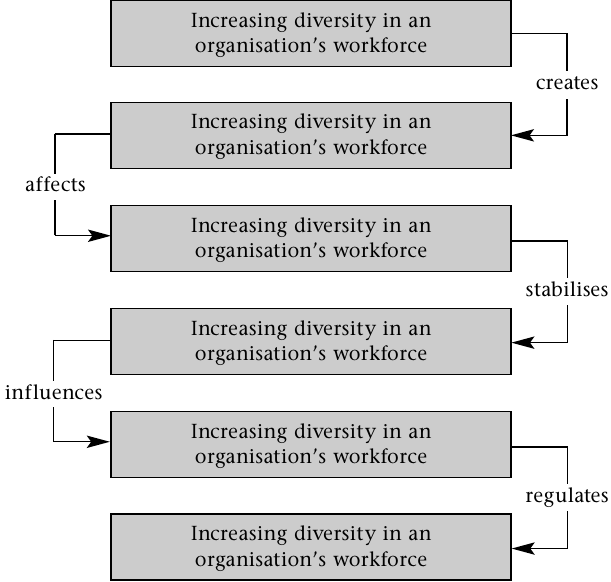
Figure 1: An adaptation of Hopkins’ process model of Ethics – diversity relationships (Hopkins, 1997,